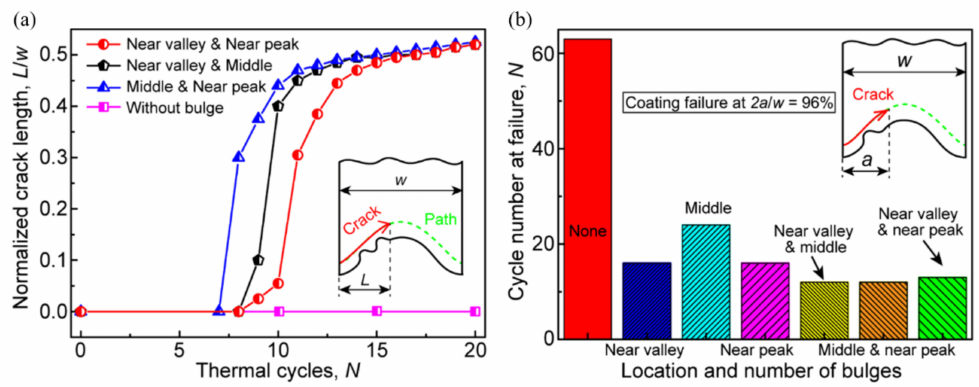
Figure 15. Effects of the location and number of bulges on the coating failure: ( a ) variation of the total crack length with the thermal cycles under different locations of two bulges and ( b ) the cycle number at the TBC failure under different bulge